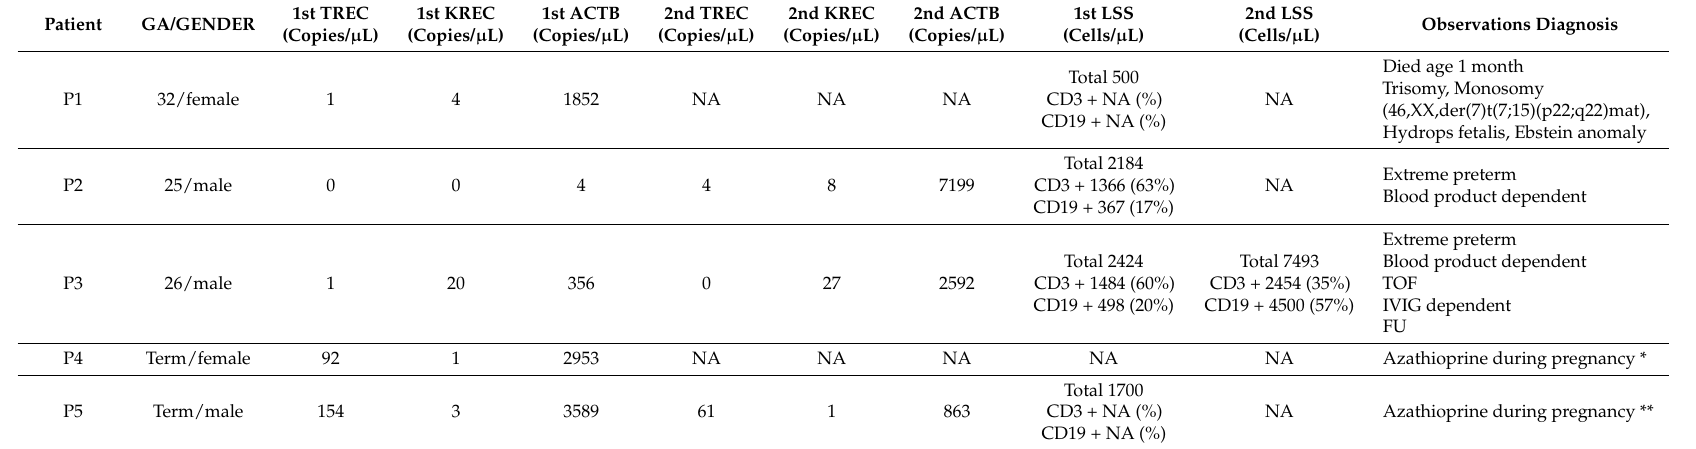
Table 2. Summary of pathological results from prospective DBS